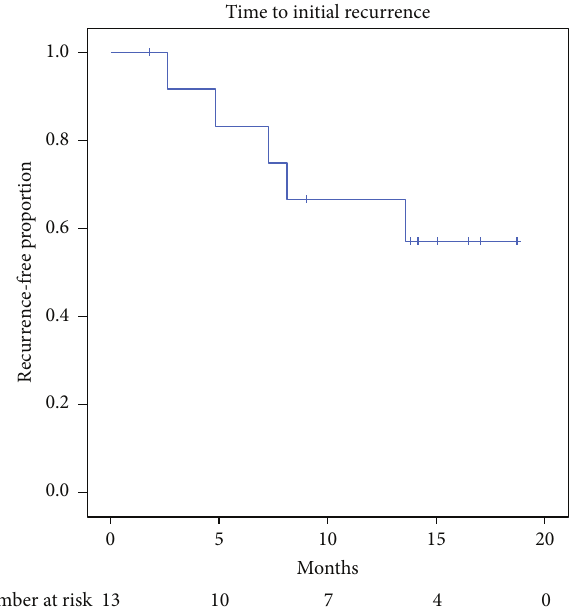
Figure 1: Time to stenosis recurrence following first transurethral incision of bladder neck stenosis with intralesional mitomycin C (MMC) injection in MMC-na¨ıve patients. Censored cases marked by vertical